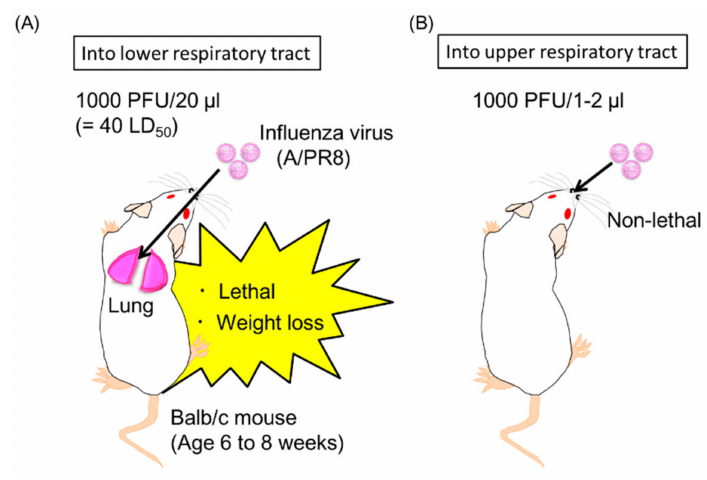
Figure 5. Mouse models of the influenza virus (A/PR8) infection [62]. ( A ) Into lower respiratory tract; ( B ) Into upper respiratory